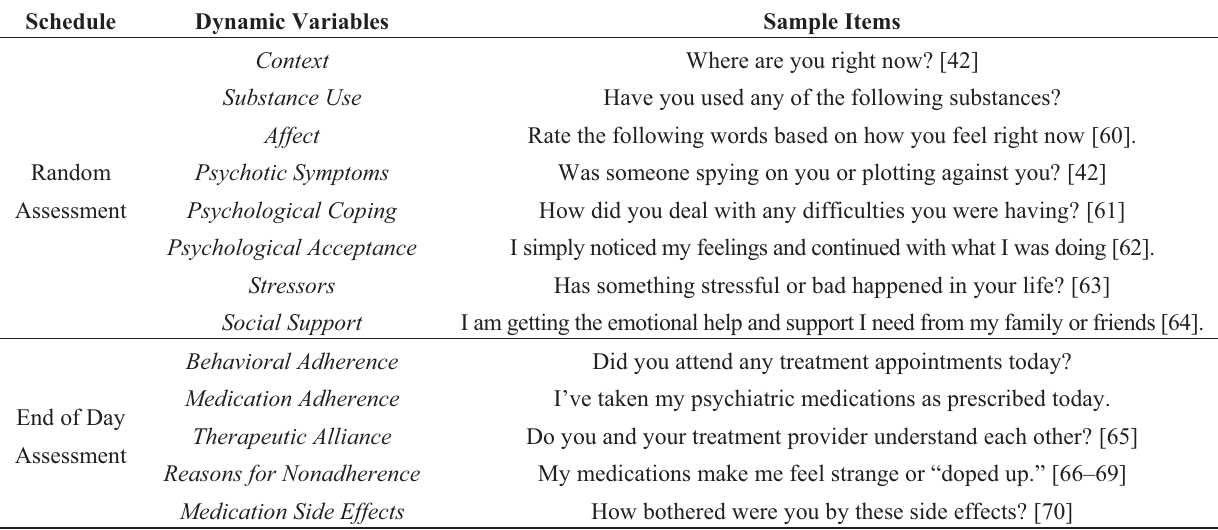
Table 1. Ecological Momentary Assessment (EMA)